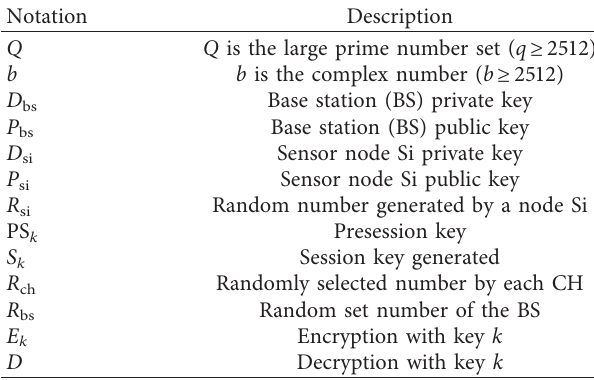
Table 1: Abbreviations and